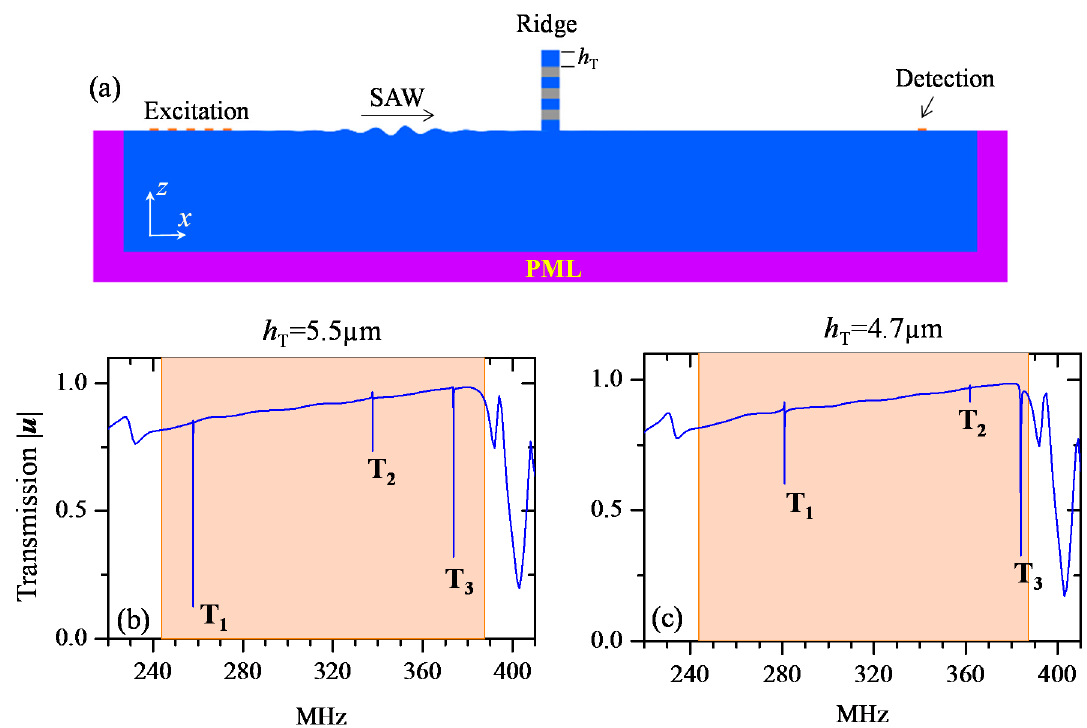
Figure 6. ( a ) Schematic view of the model used for the transmission calculation through one phononic ridge. ( b , c ), Transmission spectra: normalized total displacement’s amplitude for h T = 5.5 µ m ( b ) and h T = 4.7 µ m ( c ). The shaded region indicates the phononic BG of the ridge.